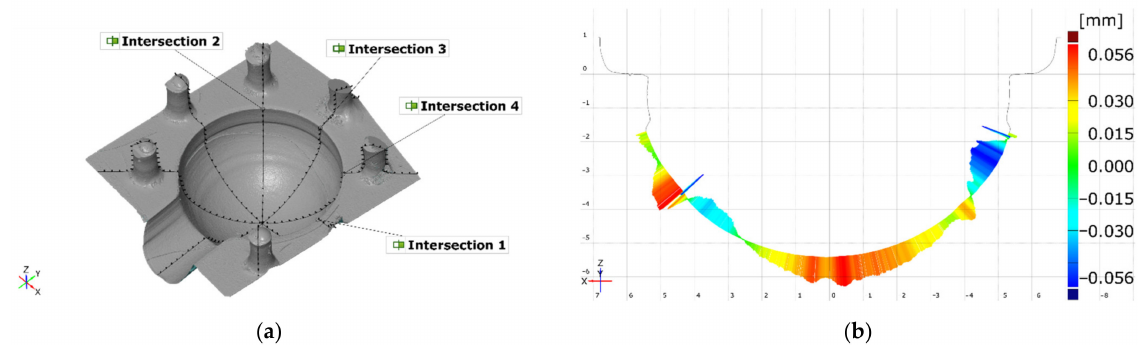
Figure 11. Visualization of the cross-sections and a fitted circle: ( a ) cross-sections as seen on the measured surface; ( b ) form deviations on a fitted circle on intersection